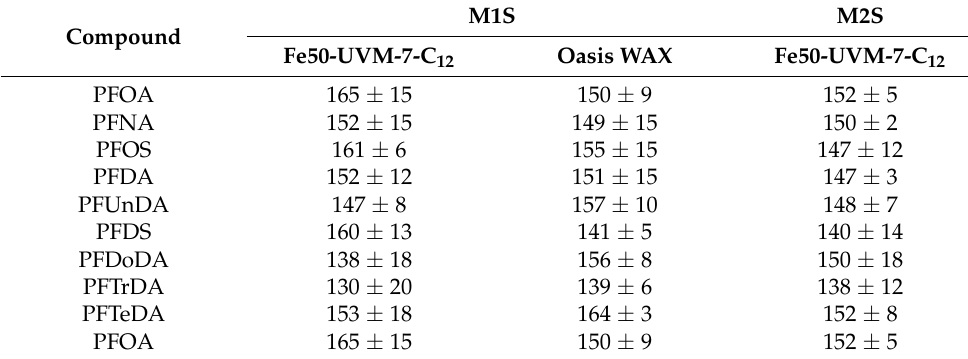
Table 4. Obtained concentrations (ng L − 1 ) of target PFASs in the analyzed spiked water samples (spiking level 150 ng L − 1 ). Compound